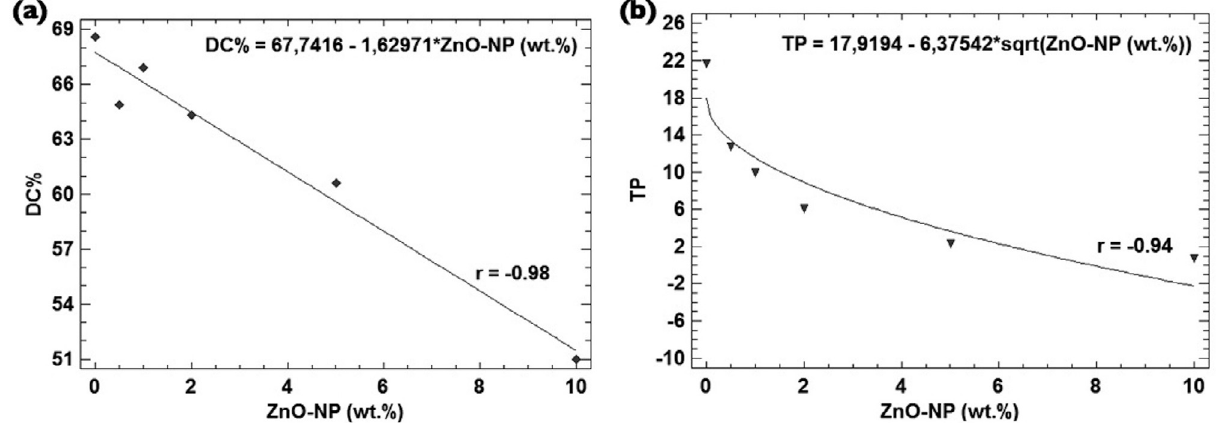
Figure 5- Linear Regression lines of (a) ZnO-NP concentration plotted against DC% (linear model), and (b) ZnO-NP concentration plotted against translucency (square-root X